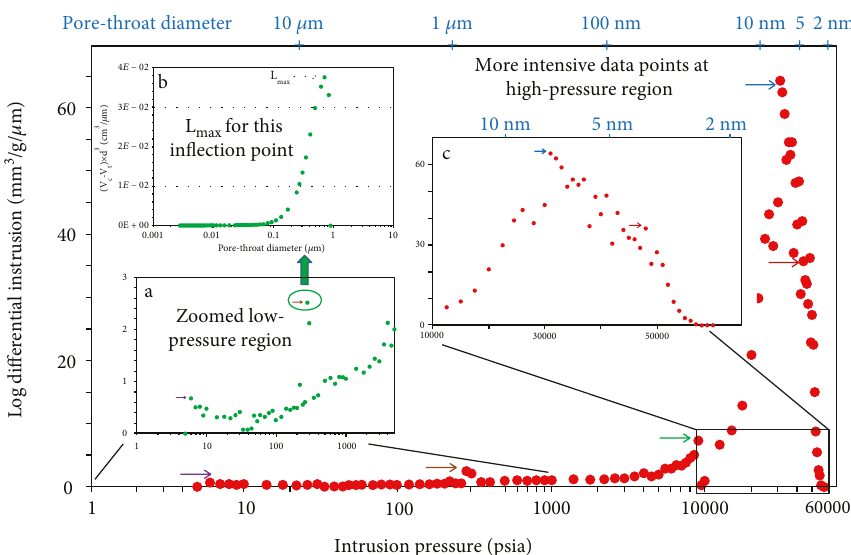
Figure 3: Log di ff erential intrusion versus intrusion pressure for example sample B-13010: (a) zoomed view for the identi fi cation of in fl ection points; (b) calculation of L from an in fl ection point; (c) intensive data collection points at high-pressure region to investigate pore volumes max with sub-nm sized pore